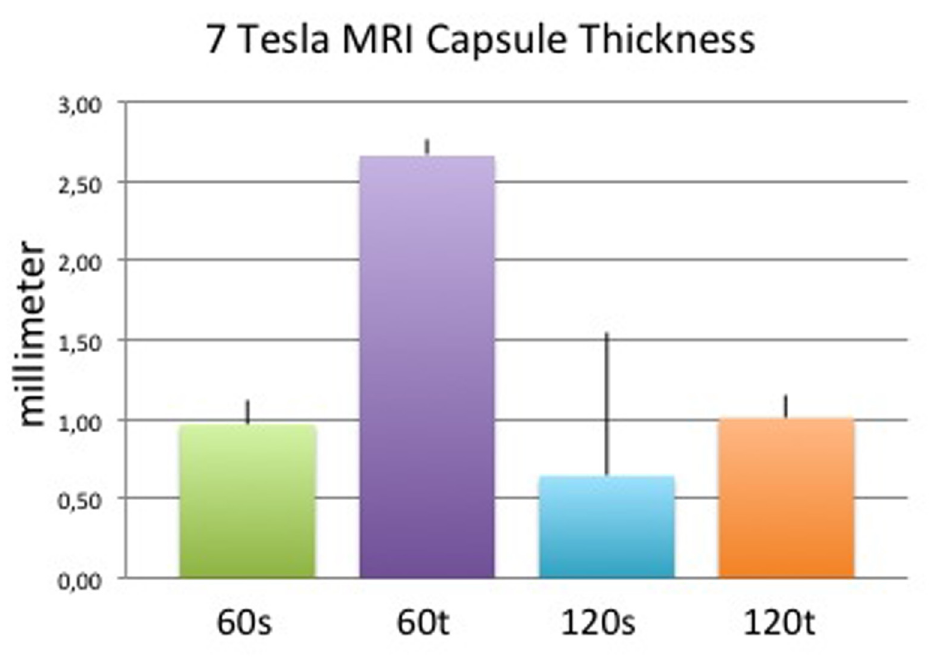
Fig 10. Mean (+/- standard deviation) capsule thickness in MRI of each study group. Results were not statistically significant.